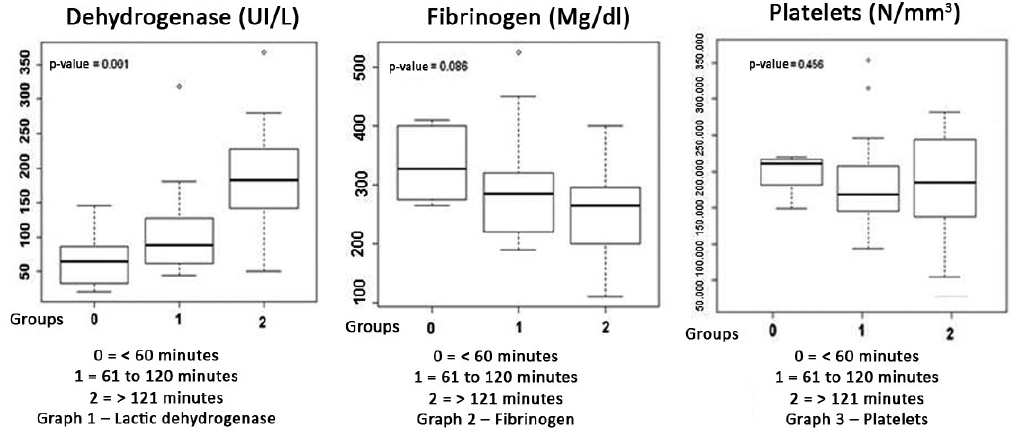
Fig. 5 - Box Plot with observed parameters during